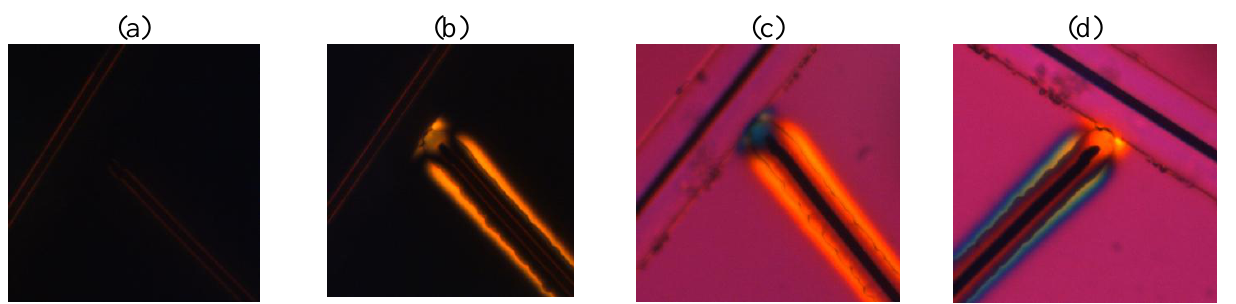
Figure 7. Polarizing microscope textures of the flat cell filled with “long/thin” Au NRs observed with crossed polarizers A and P [no field in (a) and with the field in (b) ] and with an inserted waveplate [ (c) and (d) with the field on, two different orientations of the sample showing the yellow and blue interference colors